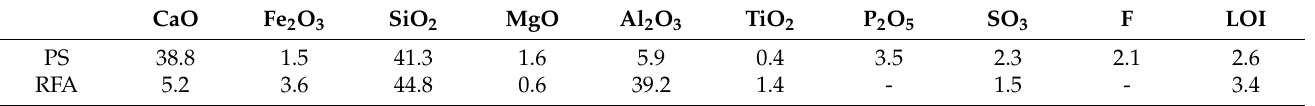
Table 1. Chemical composition of phosphorus slag and fly ash